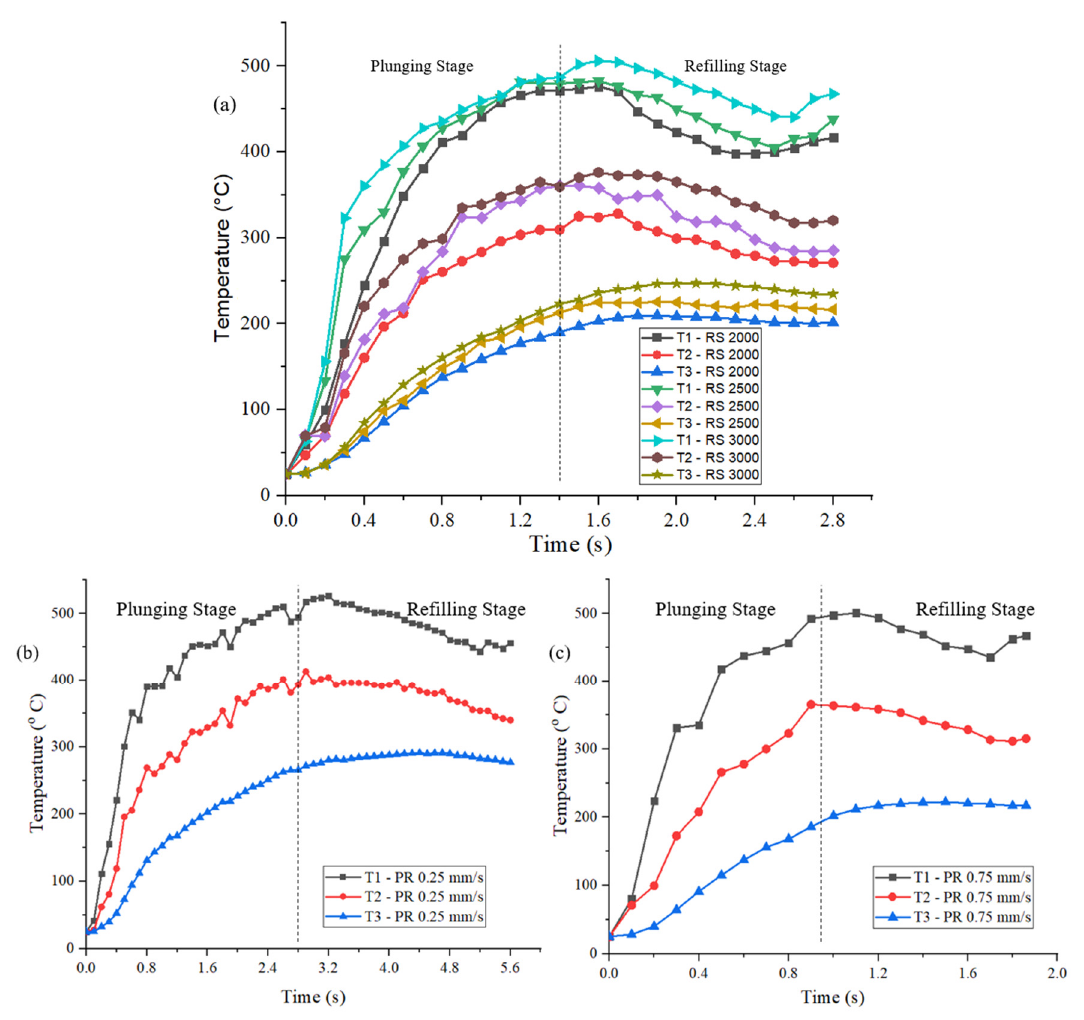
Figure 3. Temperature behavior in the numerical models at characteristic points T1, T2, and T3 of ( a ) models M1, M2, and M3; ( b ) model M4; ( c ) model M5. Table 2. Comparison of maximum temperatures from the experiment and simulation.